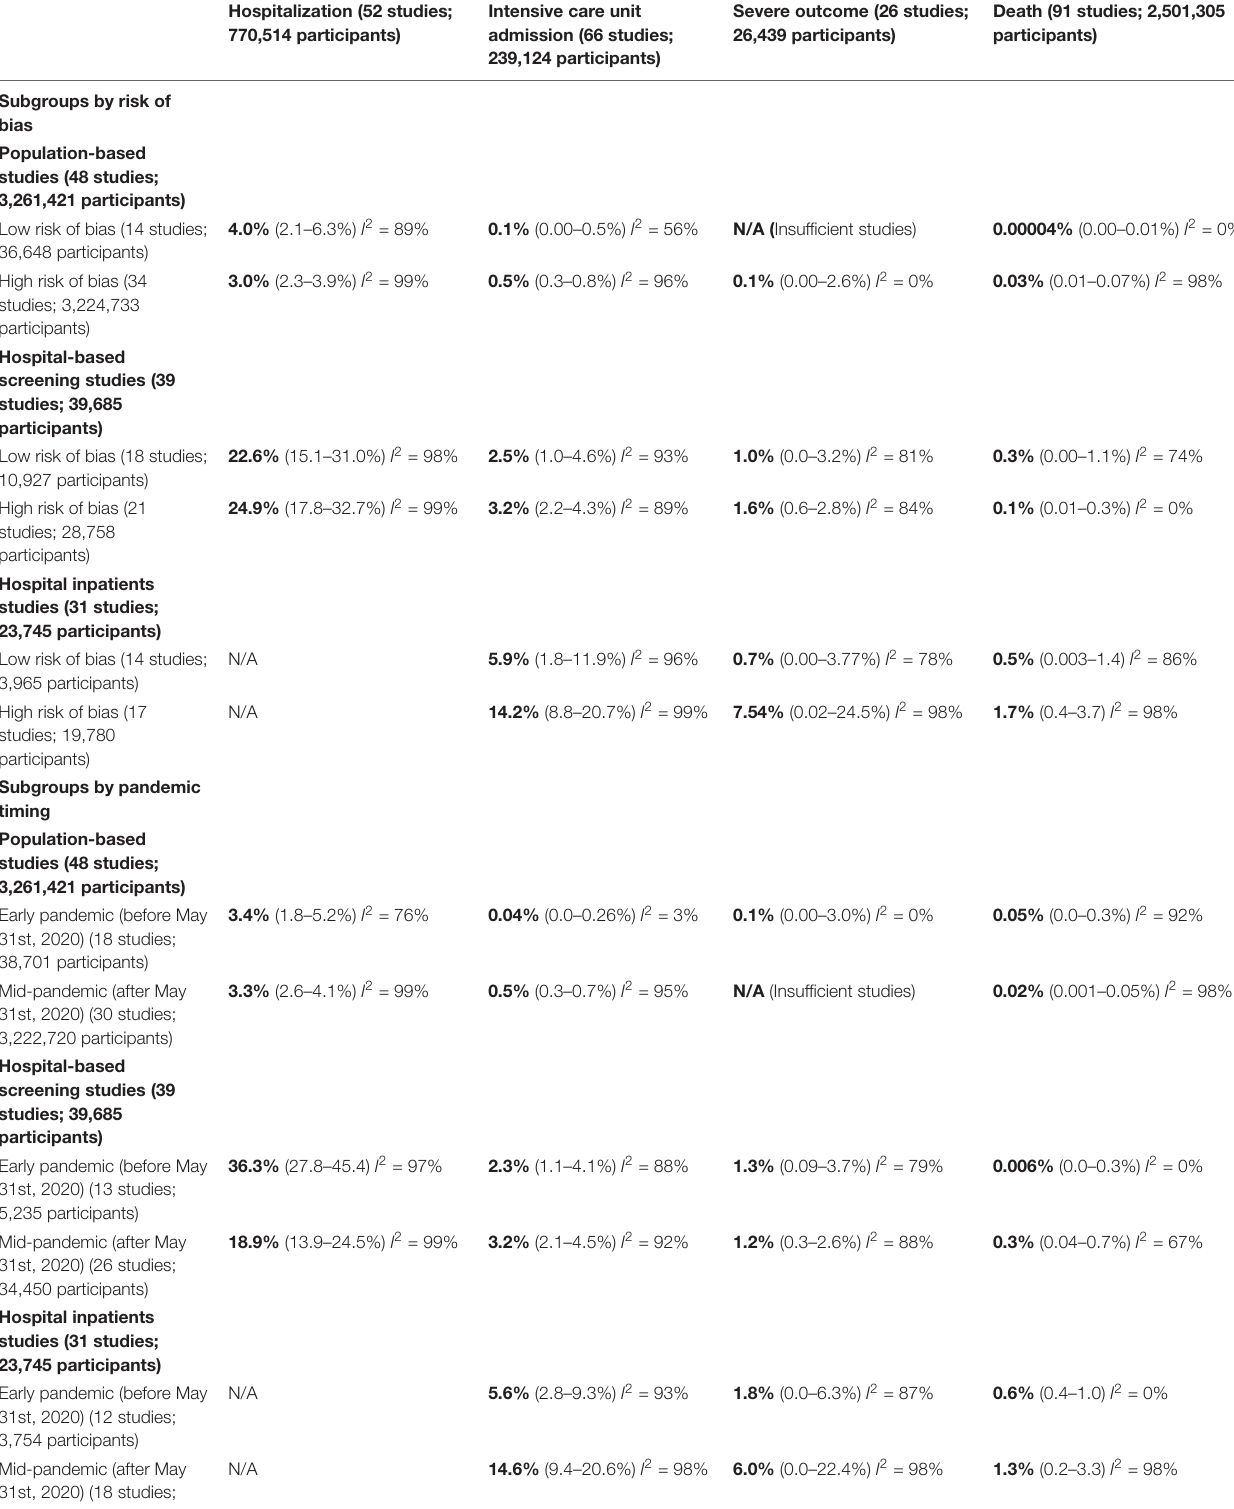
TABLE 2 | Percentage of participants experiencing outcome based on risk of bias and pandemic timing. Hospitalization (52 studies; 770,514 participants)